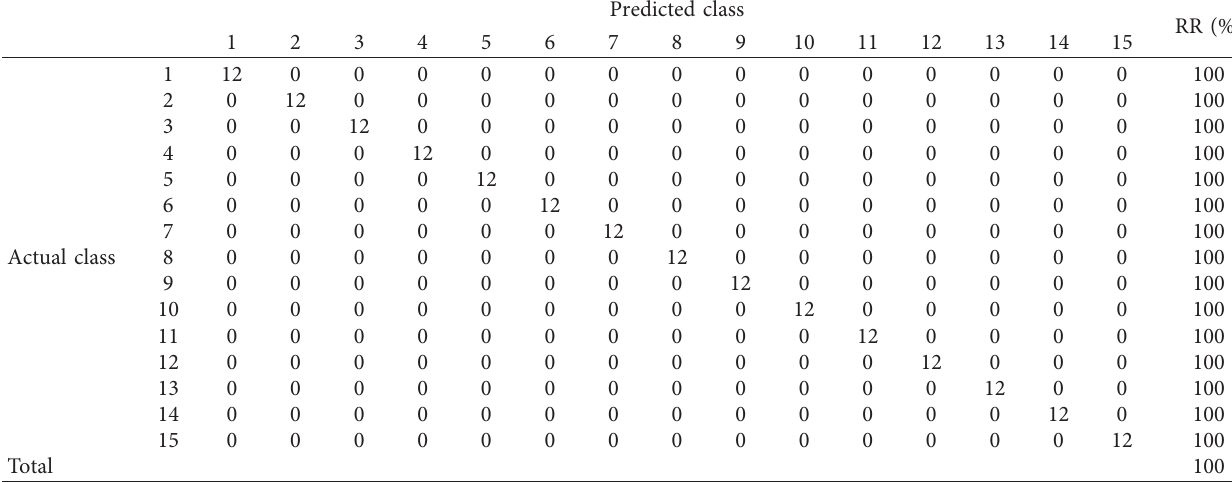
Table 5: Test sample SVM classification